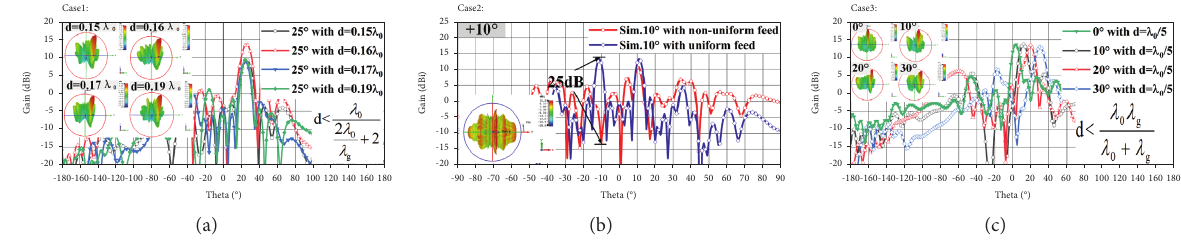
Figure 3: The solution of grating lobes and beam fixation simulated by CST. (a) Antenna patterns of different element spacings d (where � 10mm; and λ � 6 . 5mm) for dynamic metasurface antenna. (b) Antenna patterns of dynamic patch antenna with nonuniform m � 1; λ g 0 feed in CST. (c) The simulated scanning beam pattern when element spacing d is λ